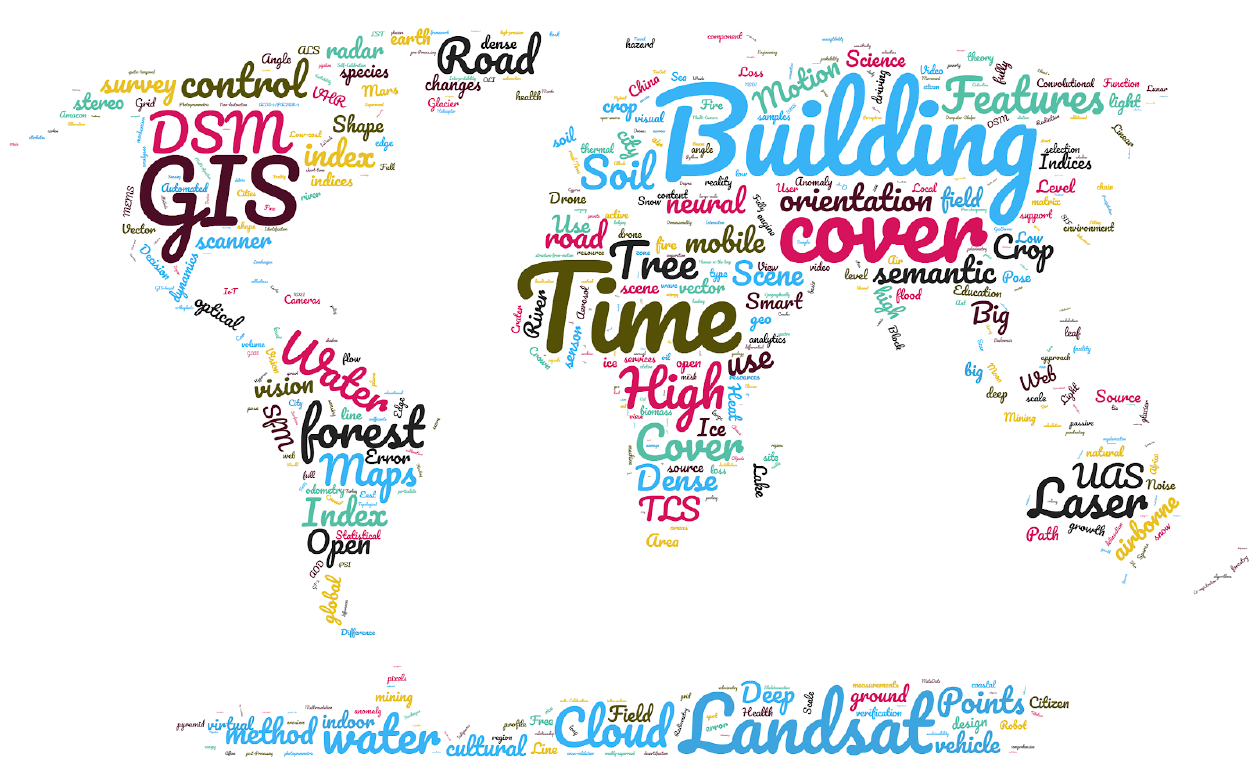
Figure 7. Word cloud based on the keywords of the submitted